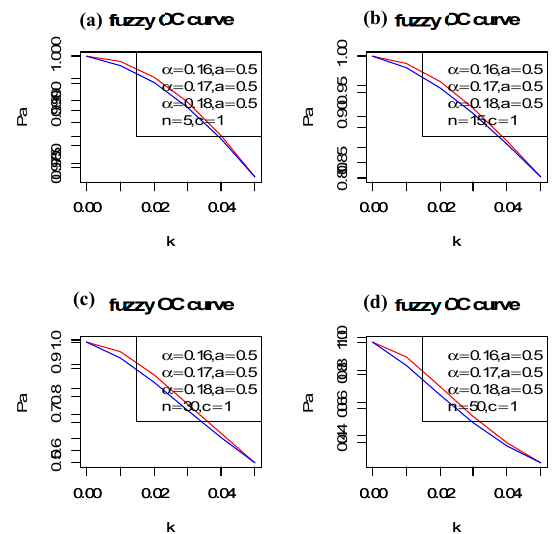
Figure 3. The fuzzy operating characteristic (OC) curve of Birnbaum-Saunders distribution at c = 1, mean ratio = 0.5, ( a ) n = 5, ( b ) n = 15, ( c ) n = 30, and ( d ) n = 50.